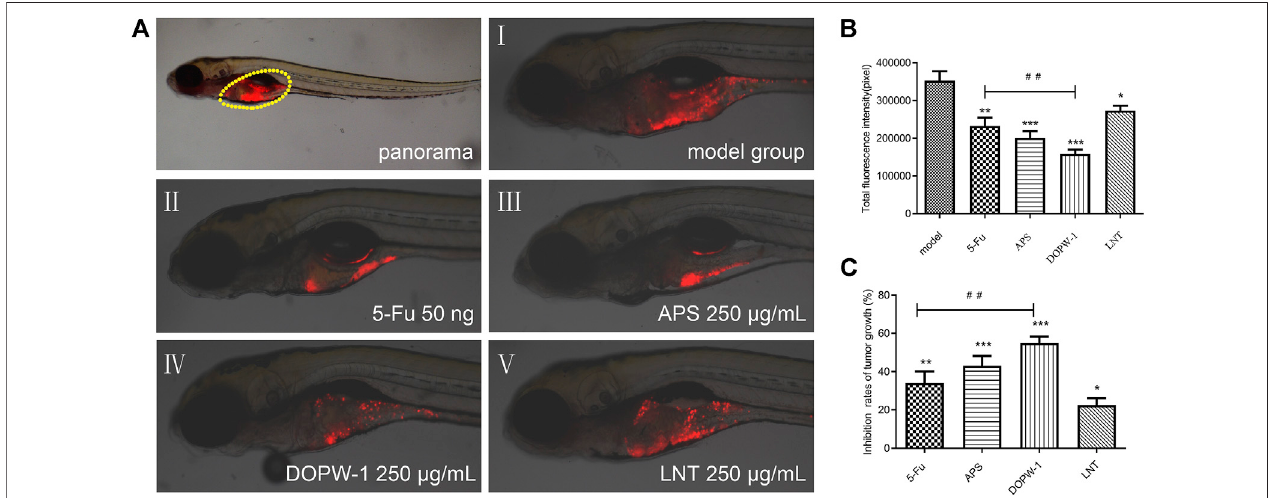
FIGURE 2 | Tumor inhibition elicited by APS, DOPW-1, and LNT in a zebra fi sh xenograft model. (A) HT-29 cells (red) after xenotransplantation. (B) Fluorescence intensity of the tumor xenograft. (C) Quanti fi cation of the inhibition of tumor growth. Data are expressed as the mean ± SEM. * P < 0.05, ** P < 0.01, and *** P < 0.001 for each group vs . the model group; ## P < 0.01 for the DOPW-1 group vs . the 5-Fu group.